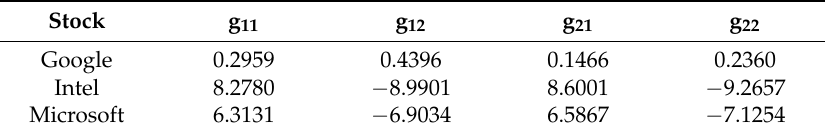
Table 7. Estimation of the transition matrix G of model (1)–(2).